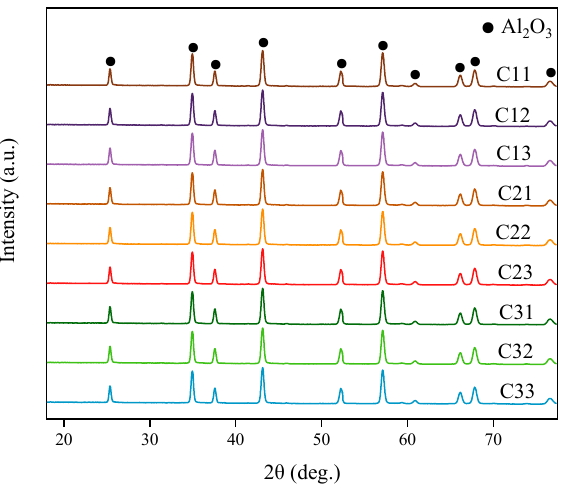
Figure 5. X-ray diffraction of porous alumina samples with 70 vol.% pore-forming agents.